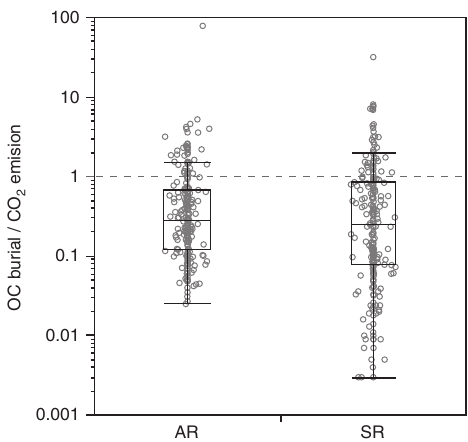
Fig. 3 OC burial compared to CO 2 emission in lakes and reservoirs in global COSCATs. The burial/emission are derived from the organic carbon (OC) burial scenarios AR (method A, inventory R, n = 230) and SR (method S, inventory R, n = 230), where values above 1 (horizontal dashed line) indicate OC burial > CO 2 emission. Each circle corresponds to one COSCAT. Box plots show median (line), interquartile range (box) and 10th – 90th percentile